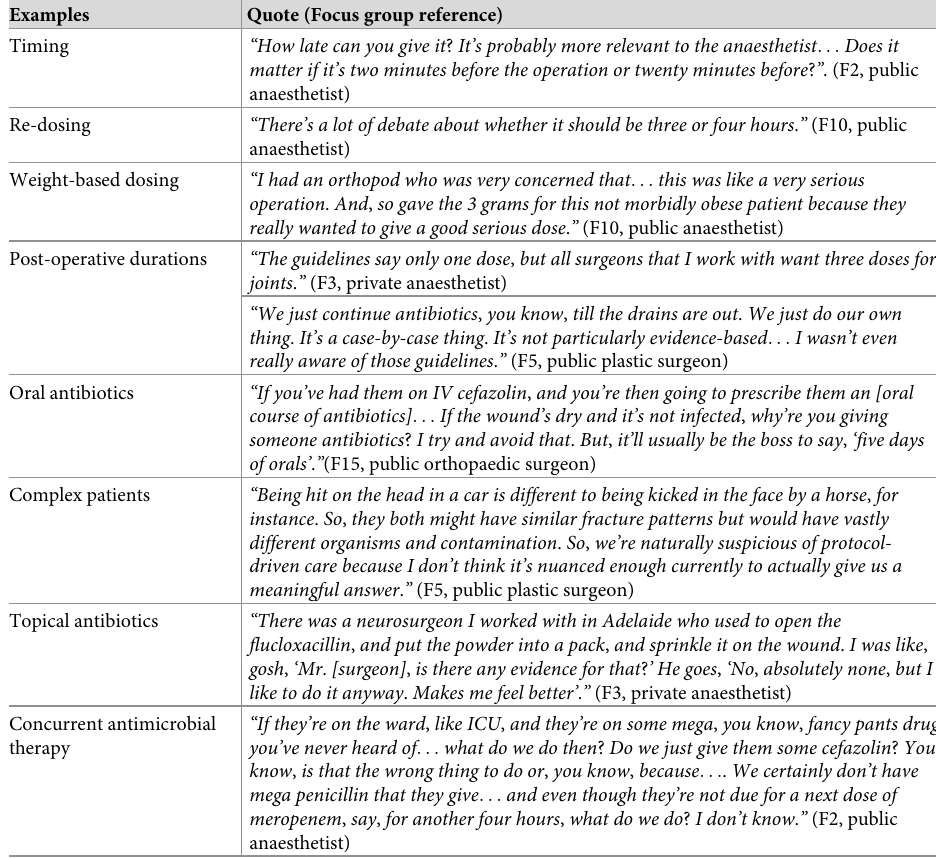
Table 4. Commonly referenced gaps in current guidelines and evidence as per